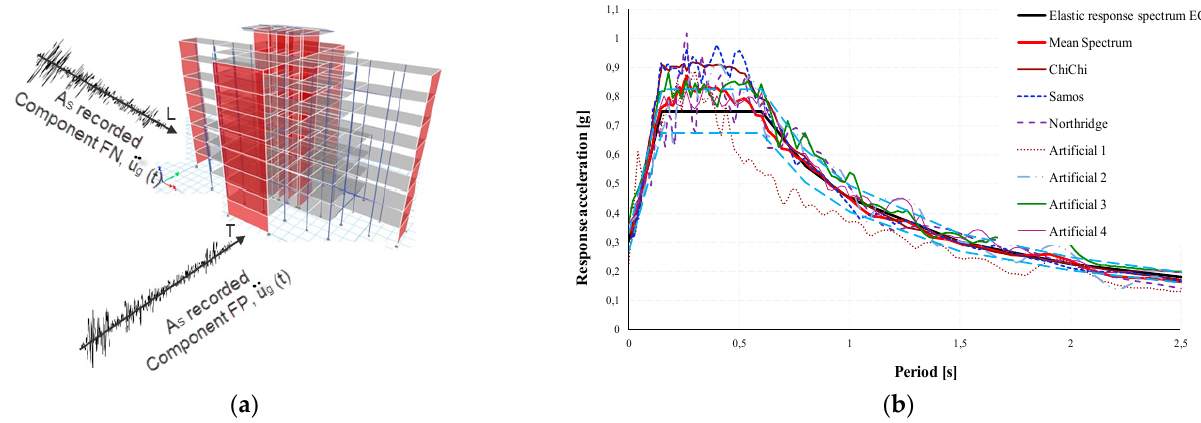
Figure 2. ( a ) The bidirectional recorded accelerograms, ( b ) response spectra relative to the selected accelerograms compared to the EC8 elastic response spectrum Type 1 with peak ground acceleration equal to 0.3 g, ground type B, and 5% damping.